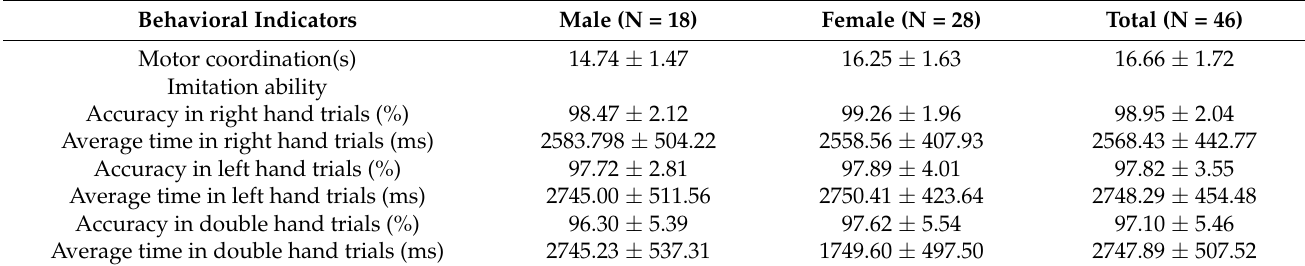
Table 2. Descriptive statistics of motor coordination and imitation ( M ± SD